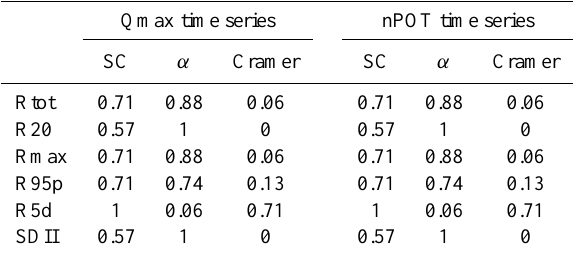
Table 8. SC and Cramer criterion values for precipitation index trends compared to Qmax trends and nPOT trends for the seven ho- mogeneous catchments in Burkina Faso, three Sahelian catchments, and four Sudanian